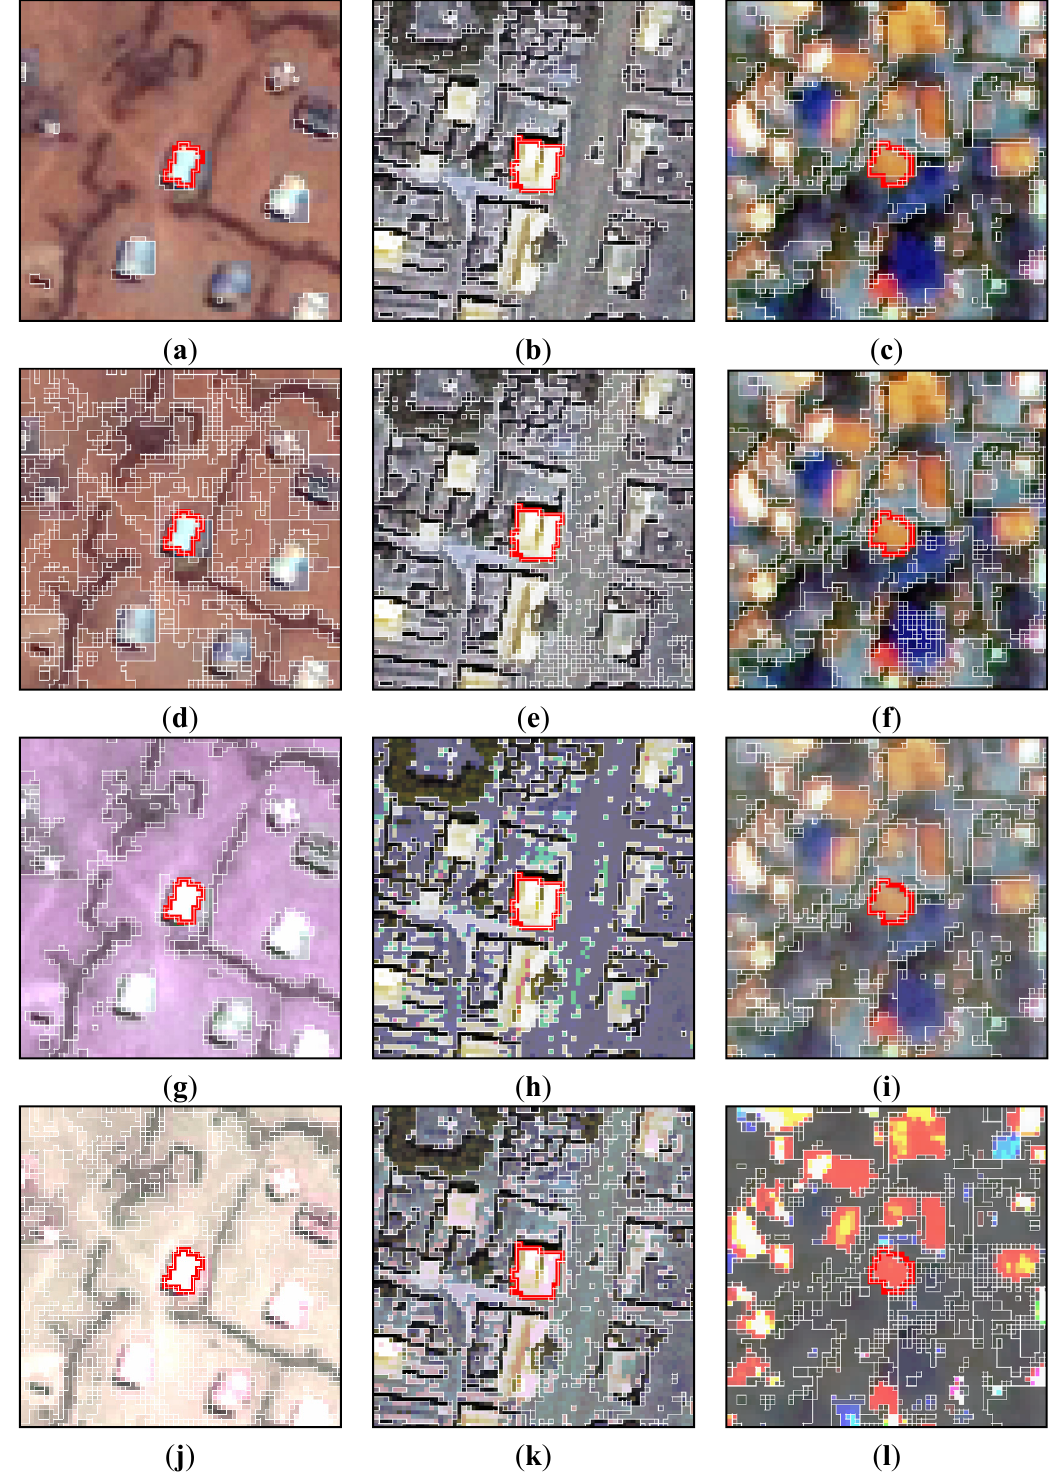
Figure 10. Exemplar optimal segmentation results focused on a random reference segment. The rows depict the CC, CC + Attr, CC + Map, and CC + Attr + Map method variants respectively (in order). The columns denote the three problems, Bokolmanyo, Jowhaar, and Hagadera (in order). ( a ) RWJ: 0.574; ( b ) RWJ: 0.524; ( c ) RWJ: 0.787; ( d ) RWJ: 0.683; ( e ) RWJ: 0.524; ( f ) RWJ: 0.806; ( g ) RWJ: 0.104; ( h ) RWJ: 0.506; ( i ) RWJ: 0.787; ( j ) RWJ: 0.063; ( k ) RWJ: 0.437; ( l ) RWJ: